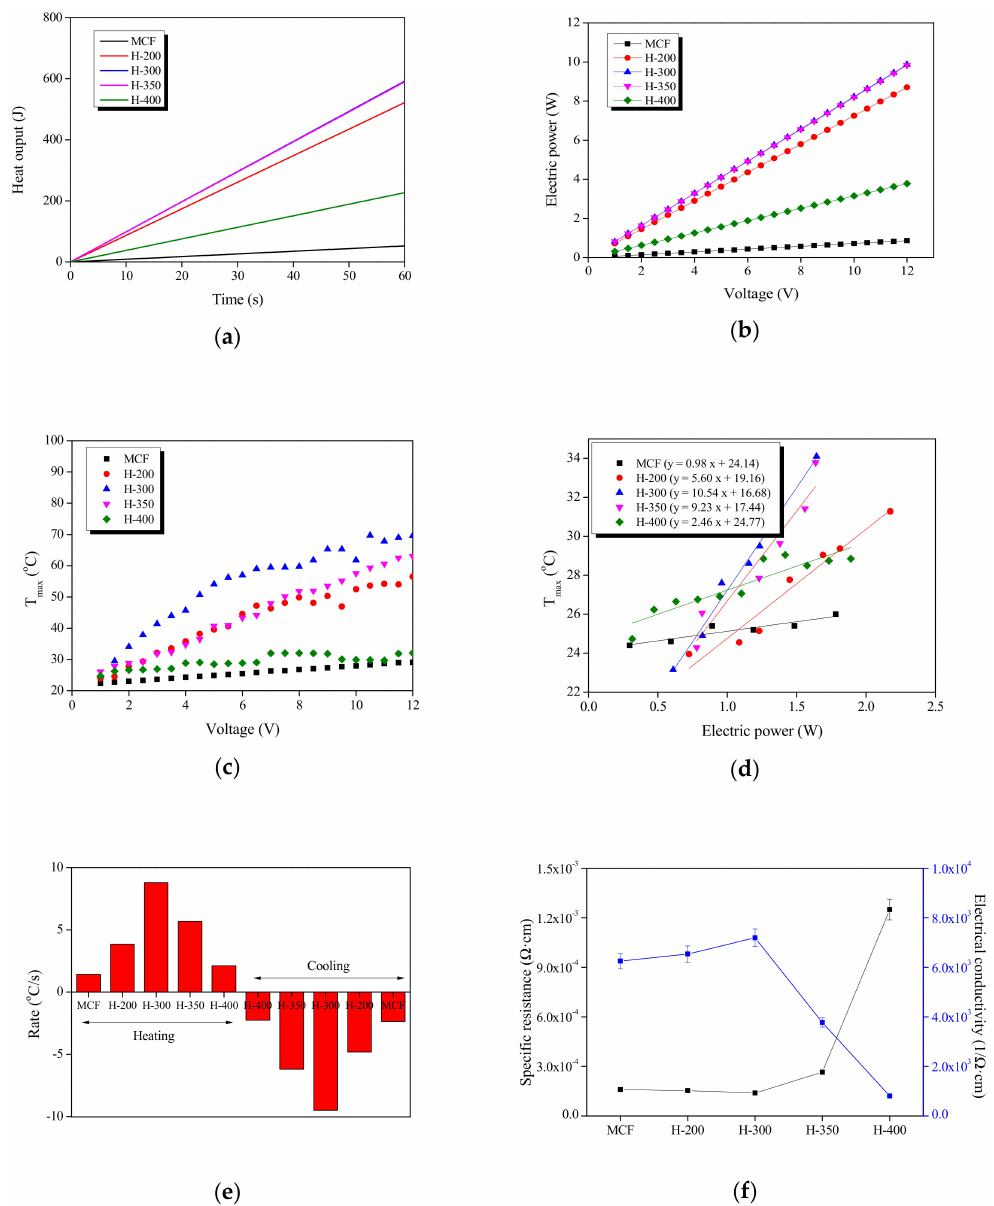
Figure 3. Thermal and electrical properties of MCF as a function of heat treatment temperature: ( a ) heat output, ( b ) electric power-voltage curves, ( c ) applied voltage changes of T max , ( d ) electric power changes of T max , ( e ) heating / cooling rate, and ( f ) electrical